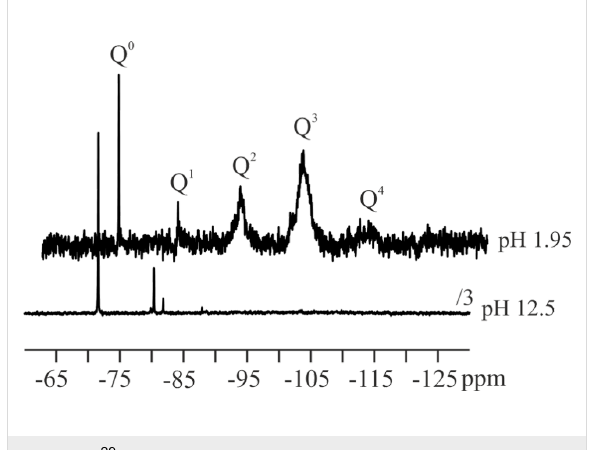
Figure 1: 29 Si HR NMR spectra of the control stock solution (75 mM SiO 2 ) in acidic and basic